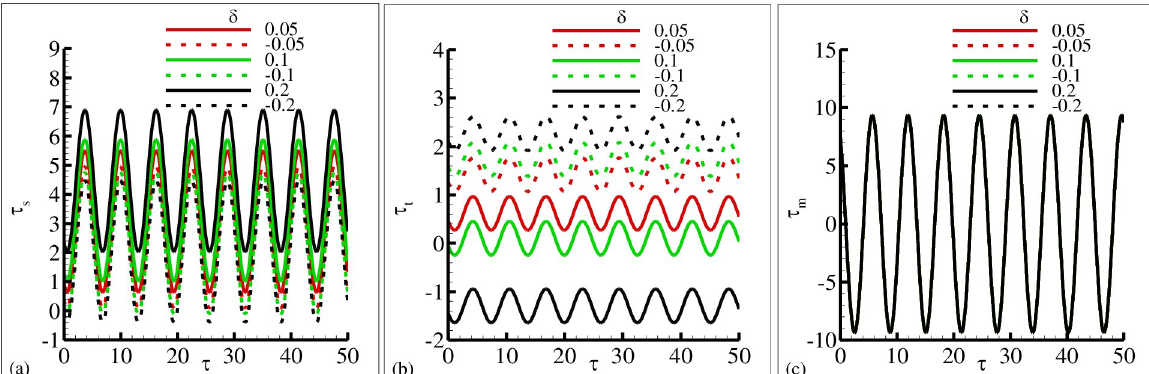
Fig 6. The graphical results of (a) τ other parameters γ = 1.6, ξ = 0.6, Pr = 7.0, O = 1.5 and λ =